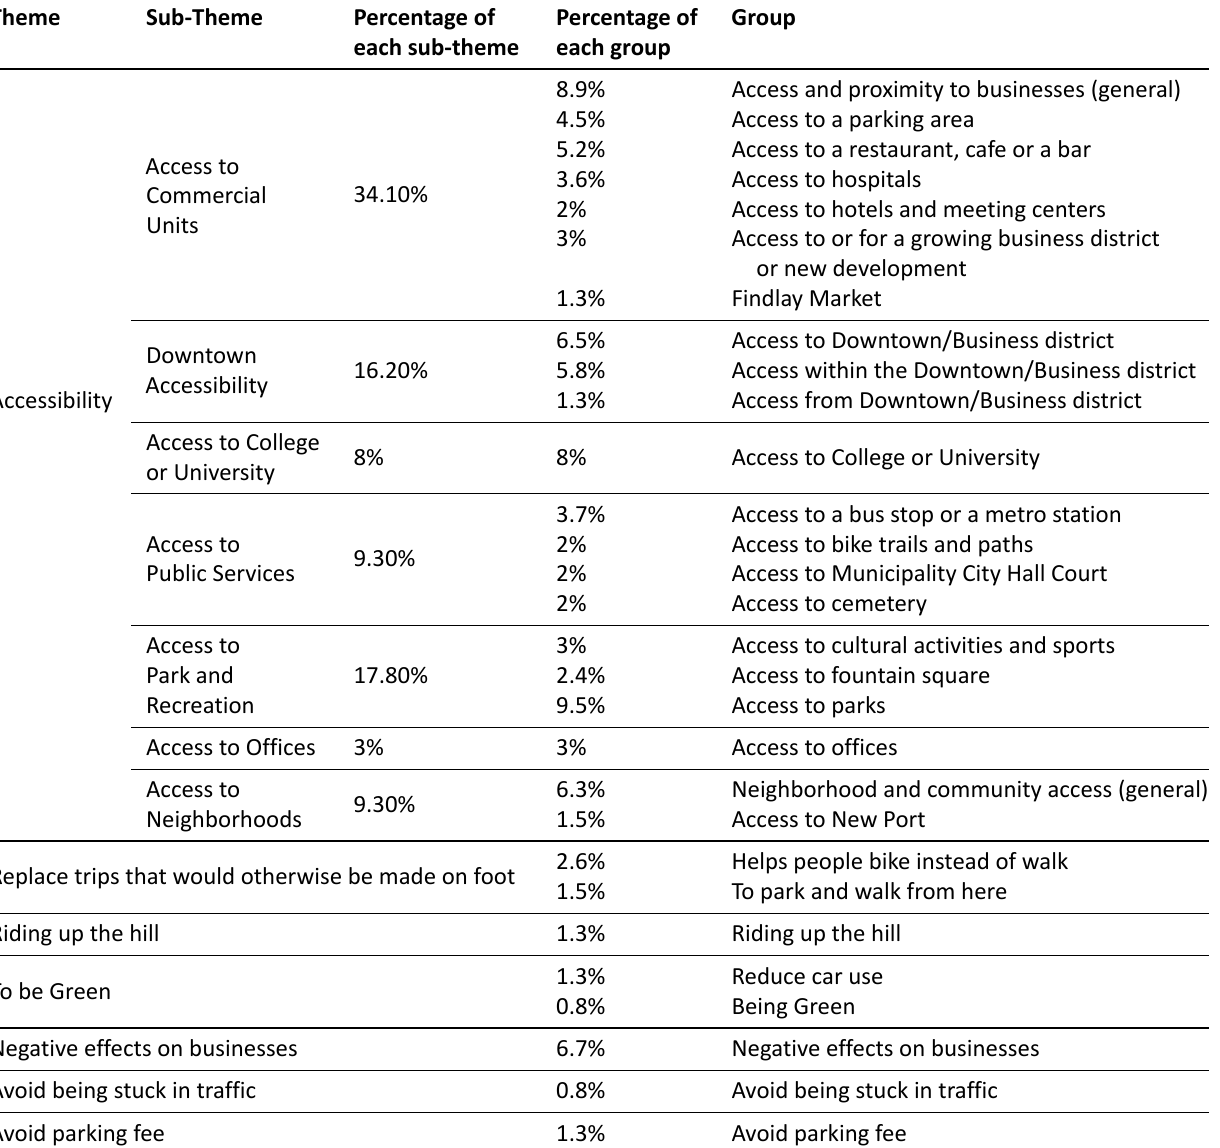
Table 3. Results of the content analysis categorized in themes, sub-themes, and